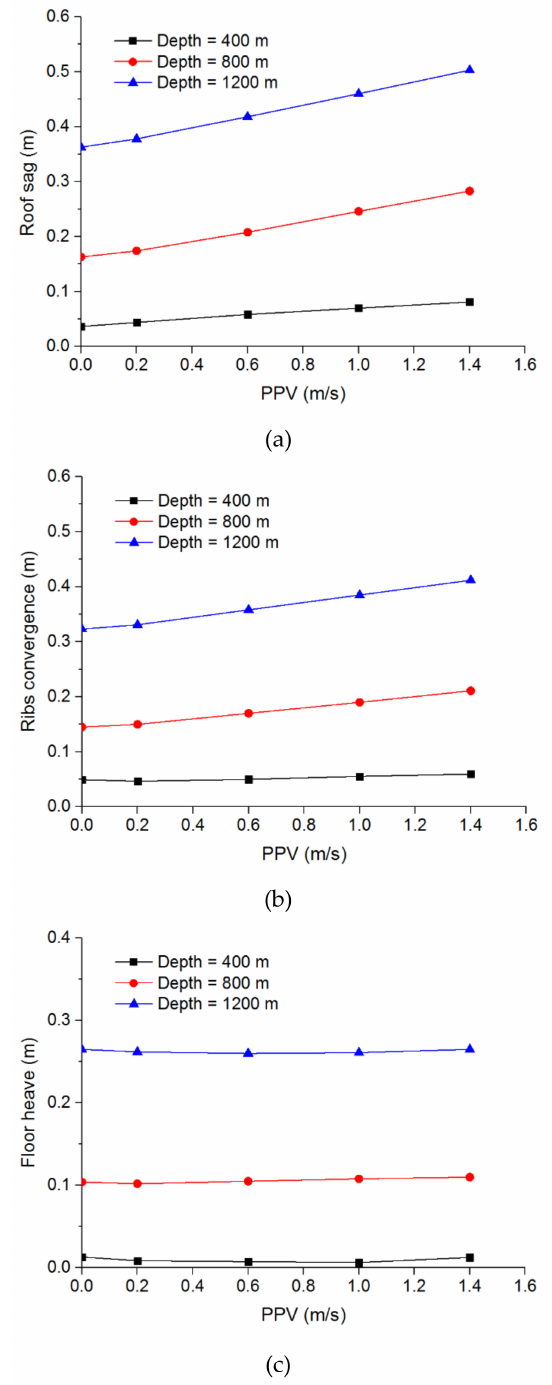
Figure 7. Deformation of the roadway under di ff erent superposed dynamic and static loads. ( a ) Roof sag under di ff erent superposed dynamic and static loads, ( b ) Ribs convergence under di ff erent superposed dynamic and static loads and ( c ) Floor heave under di ff erent superposed dynamic and static